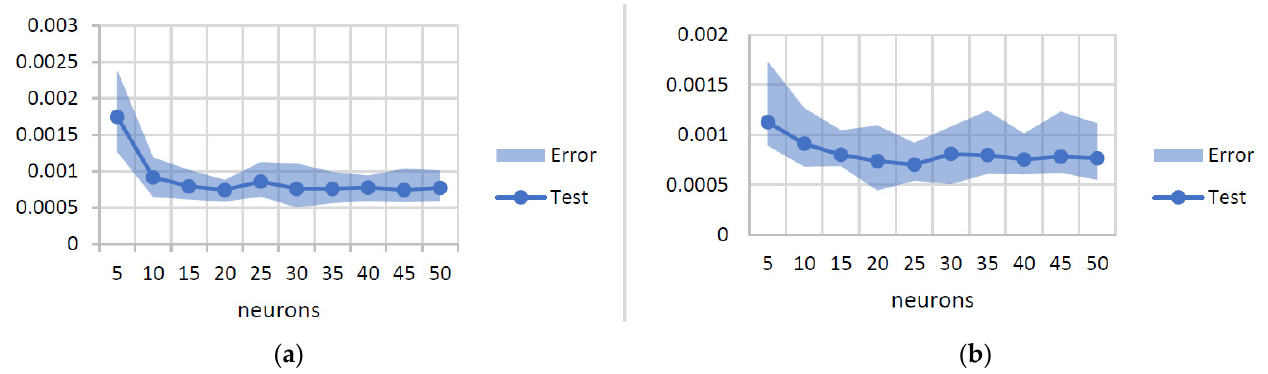
Figure 6. Evolution of the error according to the number of neurons for the ( a ) Nokia-to-Canon and ( b ) Samsung-to-Canon ANN to change the gamut. Table 3. Correlation matrix of the new RGB values after the change of gamut. The correlations that increased from those in Table 1 are indicated in bold.